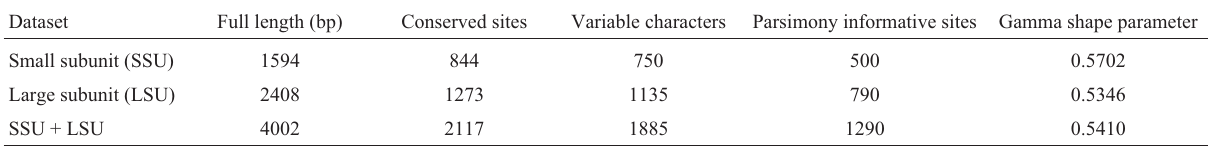
Table 1 - Basic statistics of the data sets.